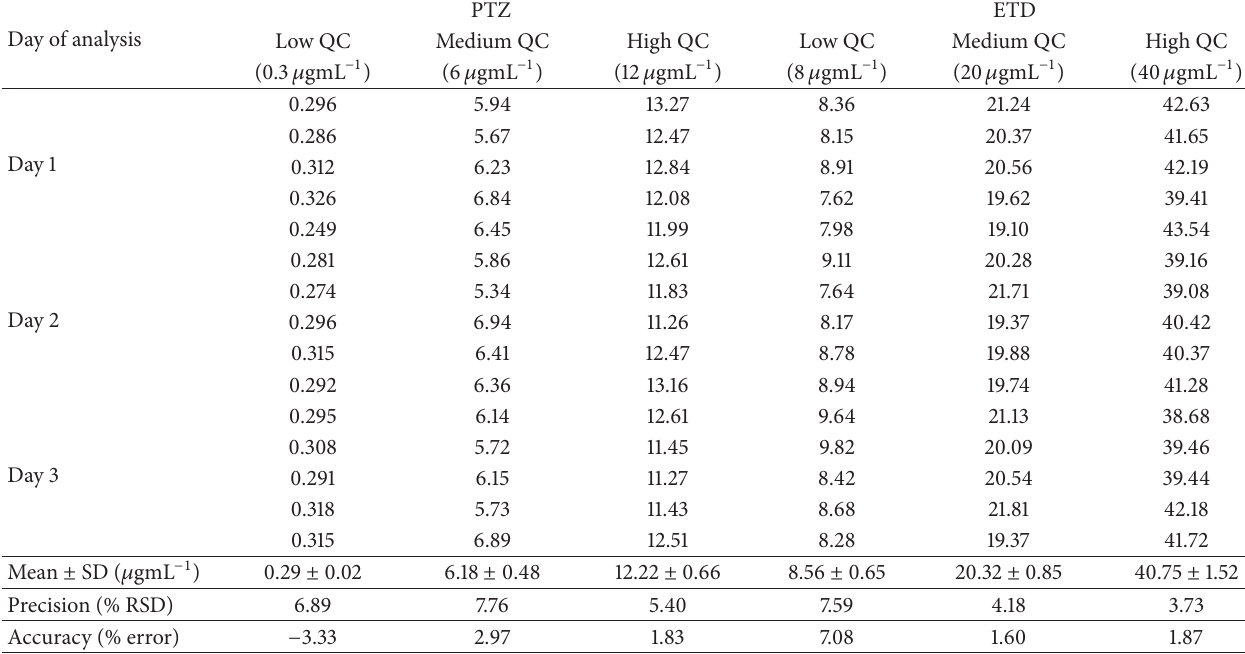
Table 3: Intraday and interday accuracy and precision of quality control samples of PTZ and ETD obtained by HPLC-DAD. Day of analysis